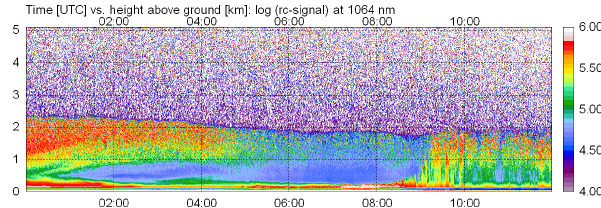
Figure 13. Time–height cross section of the range-corrected signal (in arbitrary units, logarithmic scale) of the CHX-1 from 20 Au- gust 2015 from midnight to noon (including Case B). Time is given in UTC and the height above ground in kilometers; note that the maximum height shown is not the full measurement range of the